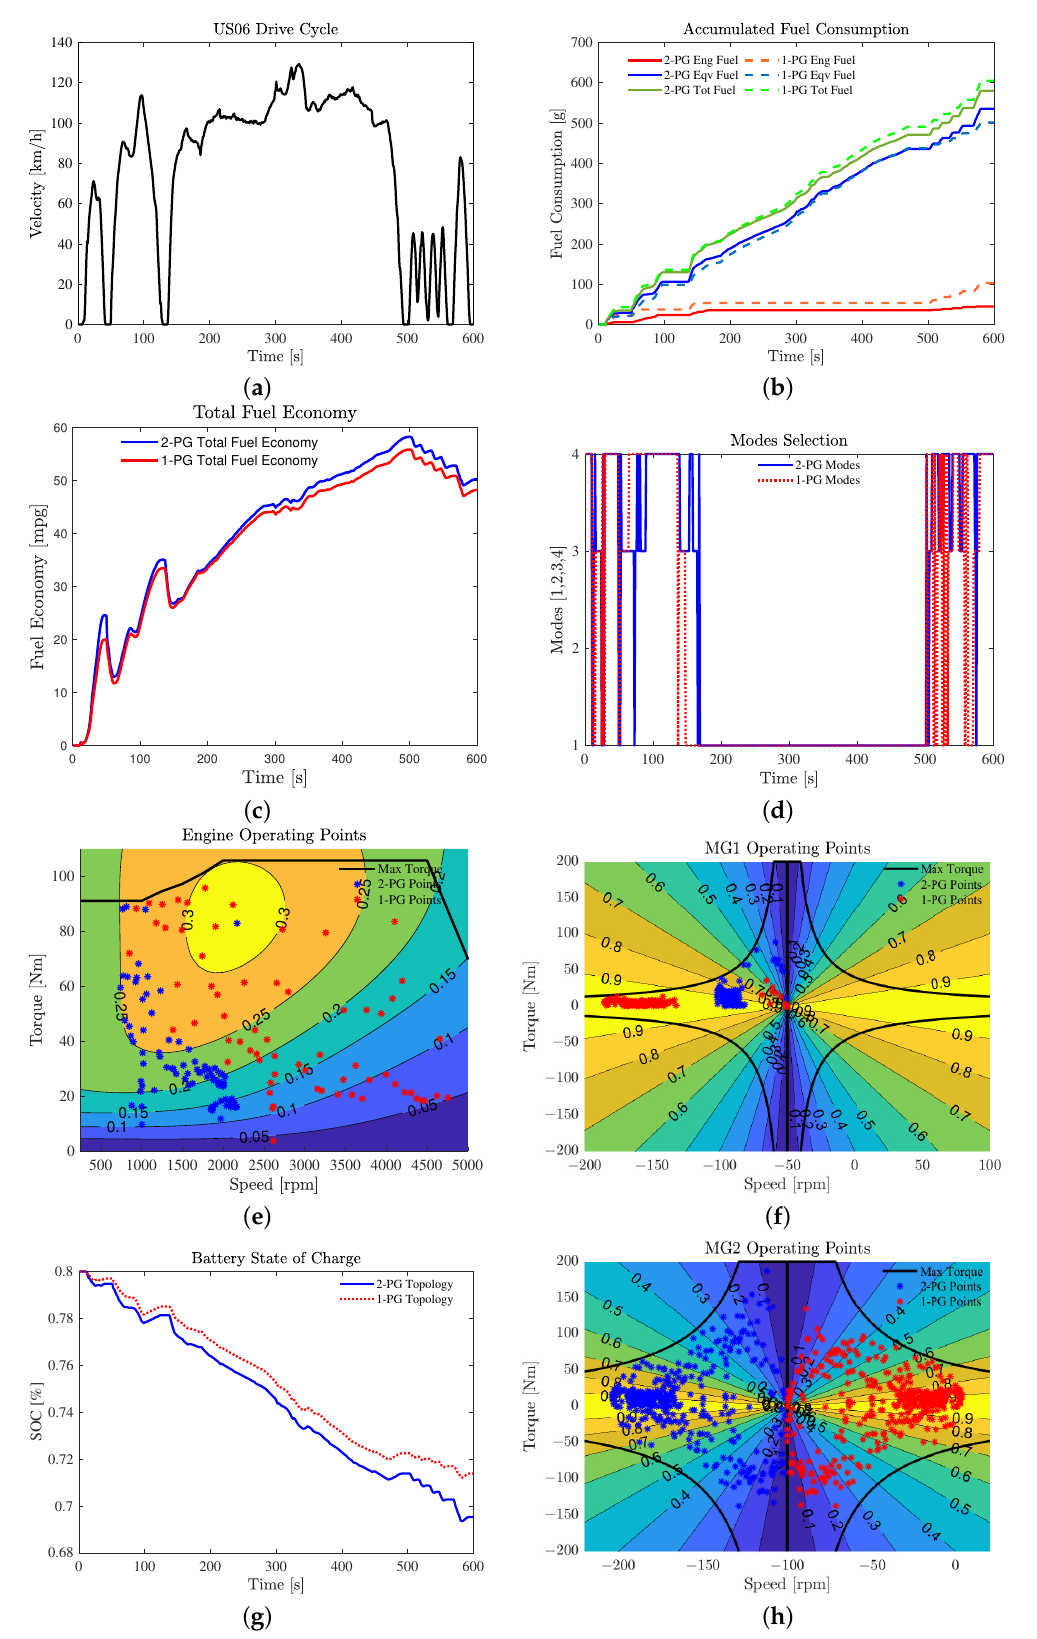
Figure 4. Simulation results for ( a ) US06 drive cycle, ( b ) Engine, equivalent, and total fuel consumption, ( c ) Total fuel economy, ( d ) Mode selection as given in Table 2, ( e ) Operating points of engine, ( f ) Operating points of MG1, ( g ) Battery state of charge for 1-PG and 2-PG topology, ( h ) Operating points of